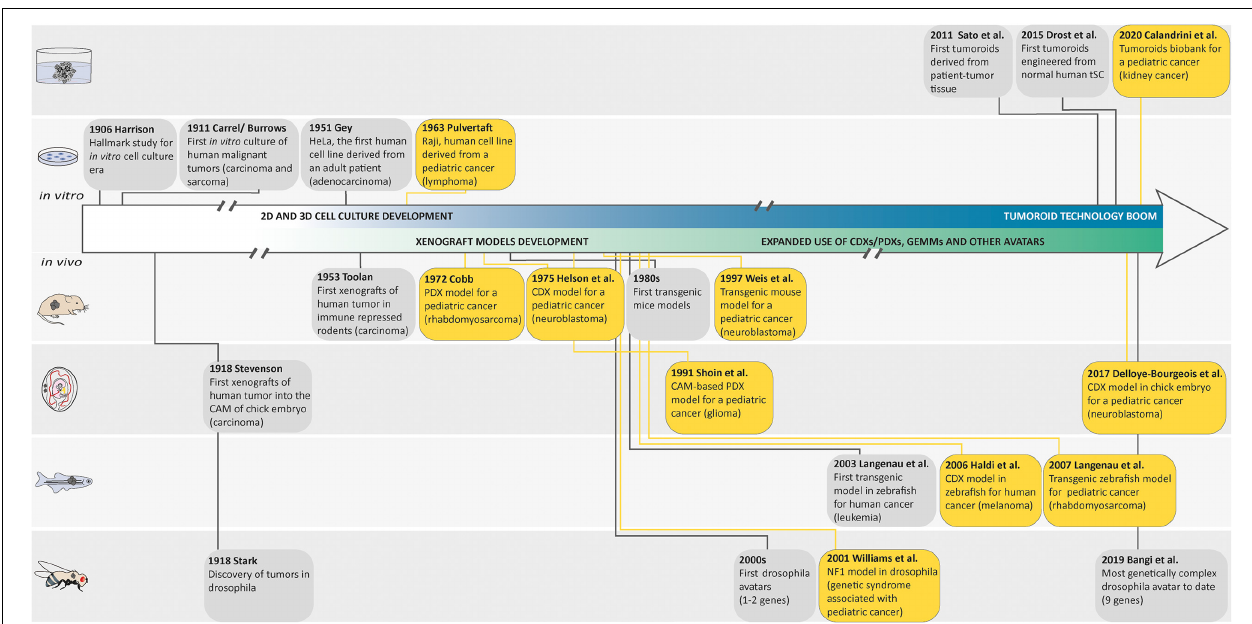
FIGURE 1 | Landmark studies in cancer model discovery. The history of cancer models can be retraced back to the early 1900s, when Harrison described the first tissue culture technique and when Carrel and Burrows defined a basic protocol to standardize the in vitro culture of human malignant tumors. Thereafter, the development of these cell culture techniques generated the first human cell line derived from a patient (HeLa) in 1951 and the Raji cell line, as one of the first pediatric cancer cell lines in 1963. In parallel with these in vitro models, many animal cancer models emerged following the discovery of tumors in drosophila in 1918, the first xenografts of human tumor in chorioallantoic membrane (CAM) of chick embryo in 1918, in immune-repressed rodents in 1953, or in zebrafish in 2006, and the generation of genetically engineered animal cancer models. Later, in order to recreate a cancer model closely mimicking the histological complexity and genetic heterogeneity of human cancers, the first tumoroids derived from a patient tumor tissue were described by Sato et al. in 2011. The first tumoroids were then engineered from normal human tissue-specific SCs and the generation of an organoid biobank for a pediatric cancer was described. Yellow boxes highlight pediatric cancer